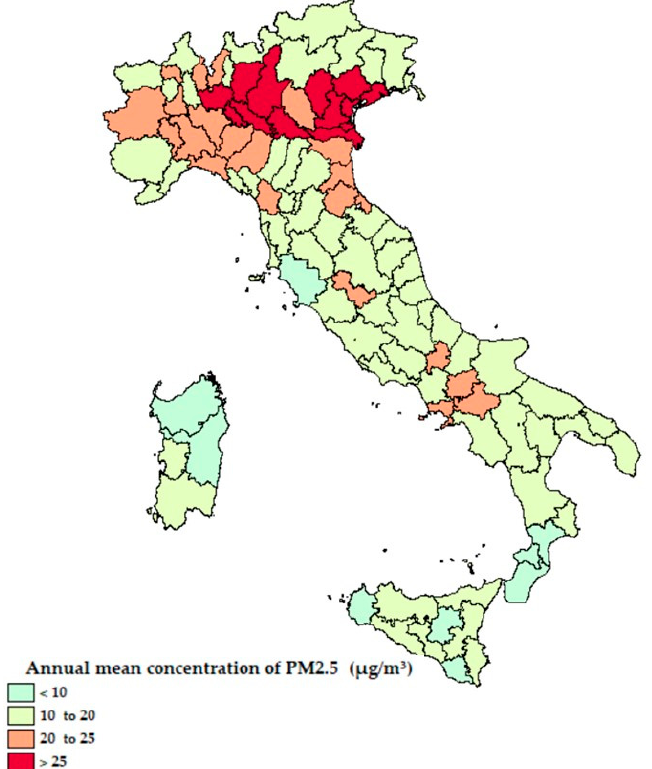
Figure 2. The annual mean concentration of fine particulate matter (PM 2.5 ) for each Italian prov- ince.